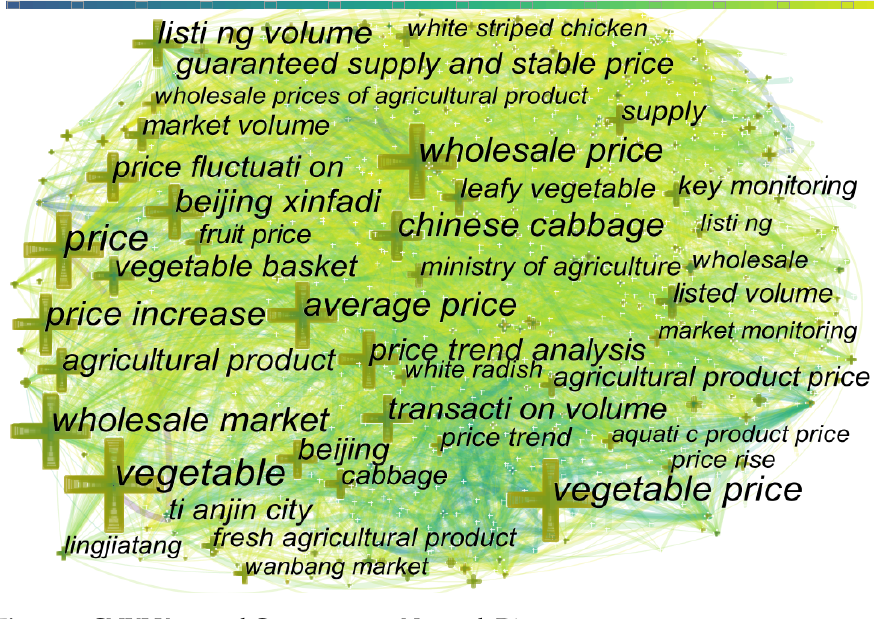
8 of 18 Table 3. Ranking of WOS Co-occurrence Citations . Id